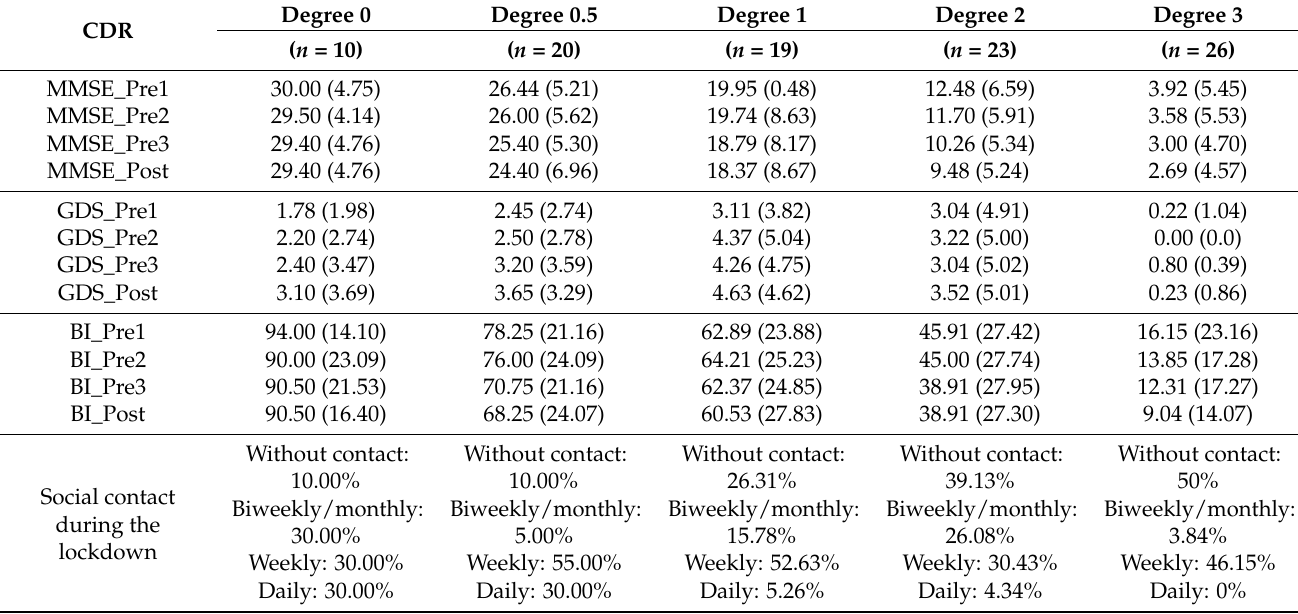
Table 2. Descriptive values (means, standard deviations between brackets) for cognitive status (MMSE scores), depression symptomatology (GDS scores), functional status (BI scores), and social-contact frequency during the lockdown according to participants’ CDR status at